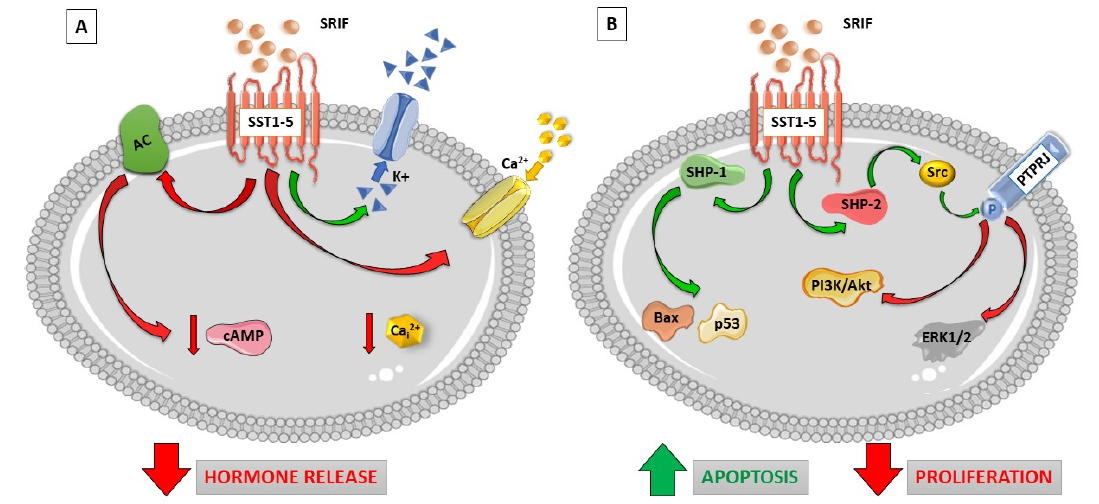
Figure 1. Diagram of the main intracellular signaling pathways triggered by agonist binding to somatostatin (SRIF) receptors to exert anti-secretory and anti-proliferative e ff ects. ( A ) Anti-secretory activity of SRIF is regulated by: i) the inhibition of adenylyl cyclase (AC), lowering cyclic adenosine monophosphate (cAMP) levels; ii) the inhibition of voltage-dependent Ca 2 + channels; and iii) the activation of outward K + channels, leading to cell membrane hyperpolarization. ( B ) Anti-proliferative e ff ects of SRIF are mediated by the activation of the protein tyrosine phosphatases Src homology 2 domain-containing protein tyrosine phosphatase 1 and 2 (SHP-1 and SHP-2) and the protein tyrosine phosphatase receptor type J (PTPRJ). SHP-1 triggers intracellular pro-apoptotic signals involving the induction of p53 and Bax, while SHP-2 activates the tyrosine kinase Src that induces the phosphorylation of PTP η , which, in turn, dephosphorylates PI3K / Akt and ERK1 / 2, impairing cell proliferation. Green arrows: Activated pathway. Red arrows: Inhibited pathways.